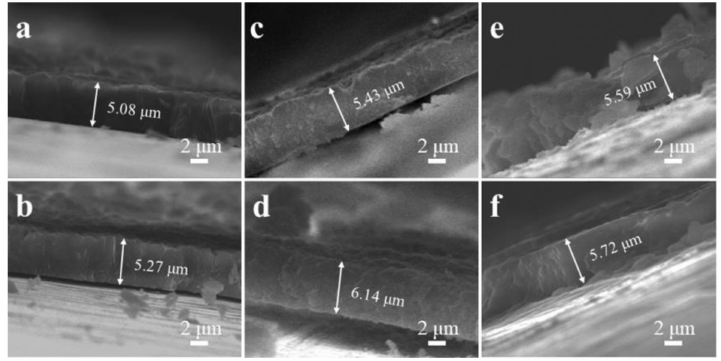
Figure 3. Cross-view SEM images of the zeolite membranes. ( a ) ZM-0TP, ( b ) ZM-0.05TP, ( c ) ZM-0.1TP, ( d ) ZM-0.15TP, ( e ) ZM-0.1TM, and ( f )